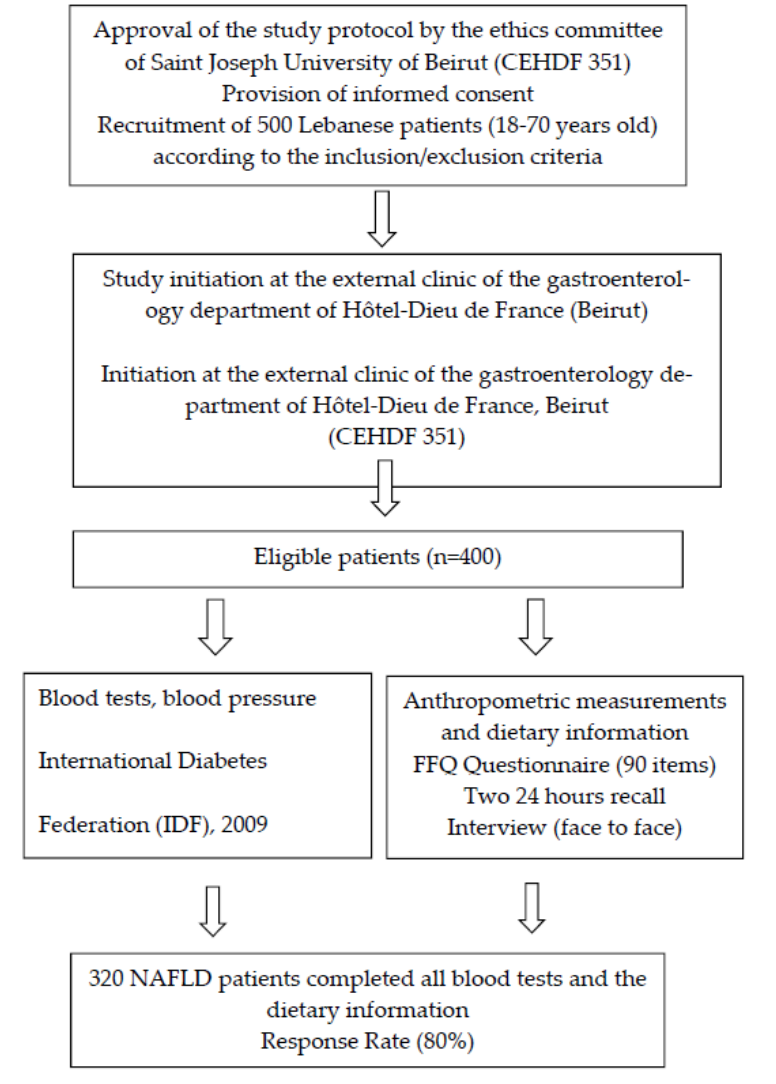
Figure 1. Flow chart for selection and enrolment of the study participants. NAFLD: Non -Alcoholic Fatty Liver Disease, FFQ Food Frequency Questionnaire [11], International Diabetes Federation (IDF) [12].